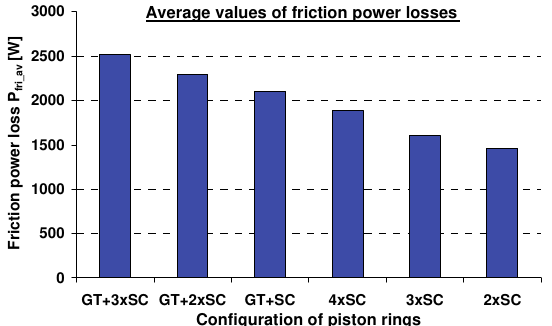
Fig. 10. Average values of total power loss P fri_av (due to hydrodynamic and mixed lubrication) for different piston ring pack configurations. Lock of the top piston ring: SC – straight-cut, GT – gas-tight